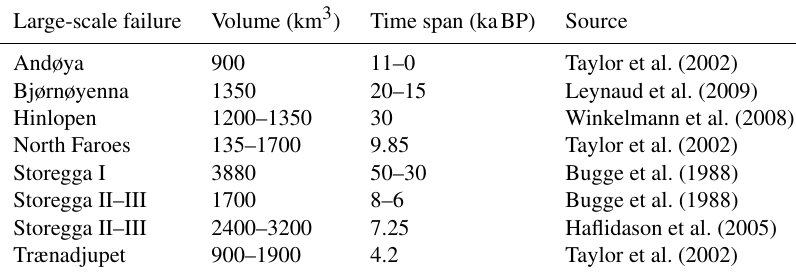
Table A2. Estimates for the volume of sediment displaced by large- scale failures.